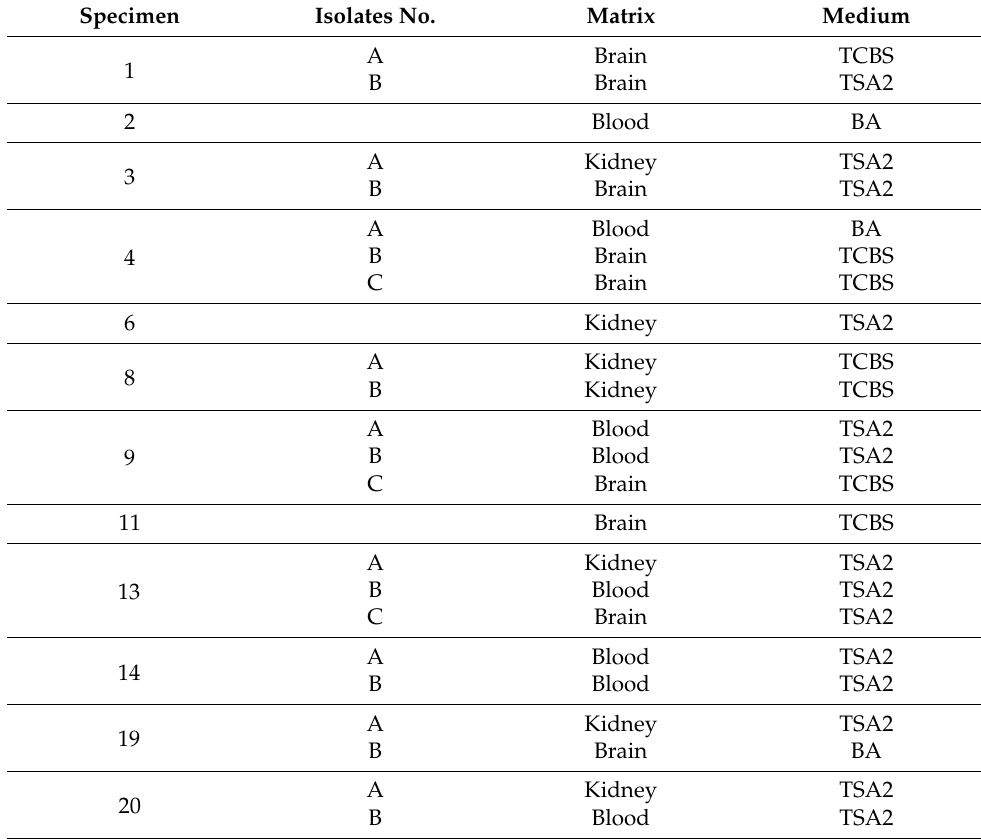
Table 1. Characteristics of the isolates. The table shows the number of sharks, the letter linked to the different isolated colonies (A, B, C; only in specimens showing more than one colony), the matrix from which the sampling was made, and the first isolation medium. Columbia blood agar (BA); tryptic soy agar supplemented with 2% NaCl (TSA2); thiosulfate citrate bile sucrose (TCBS). Specimen Isolates